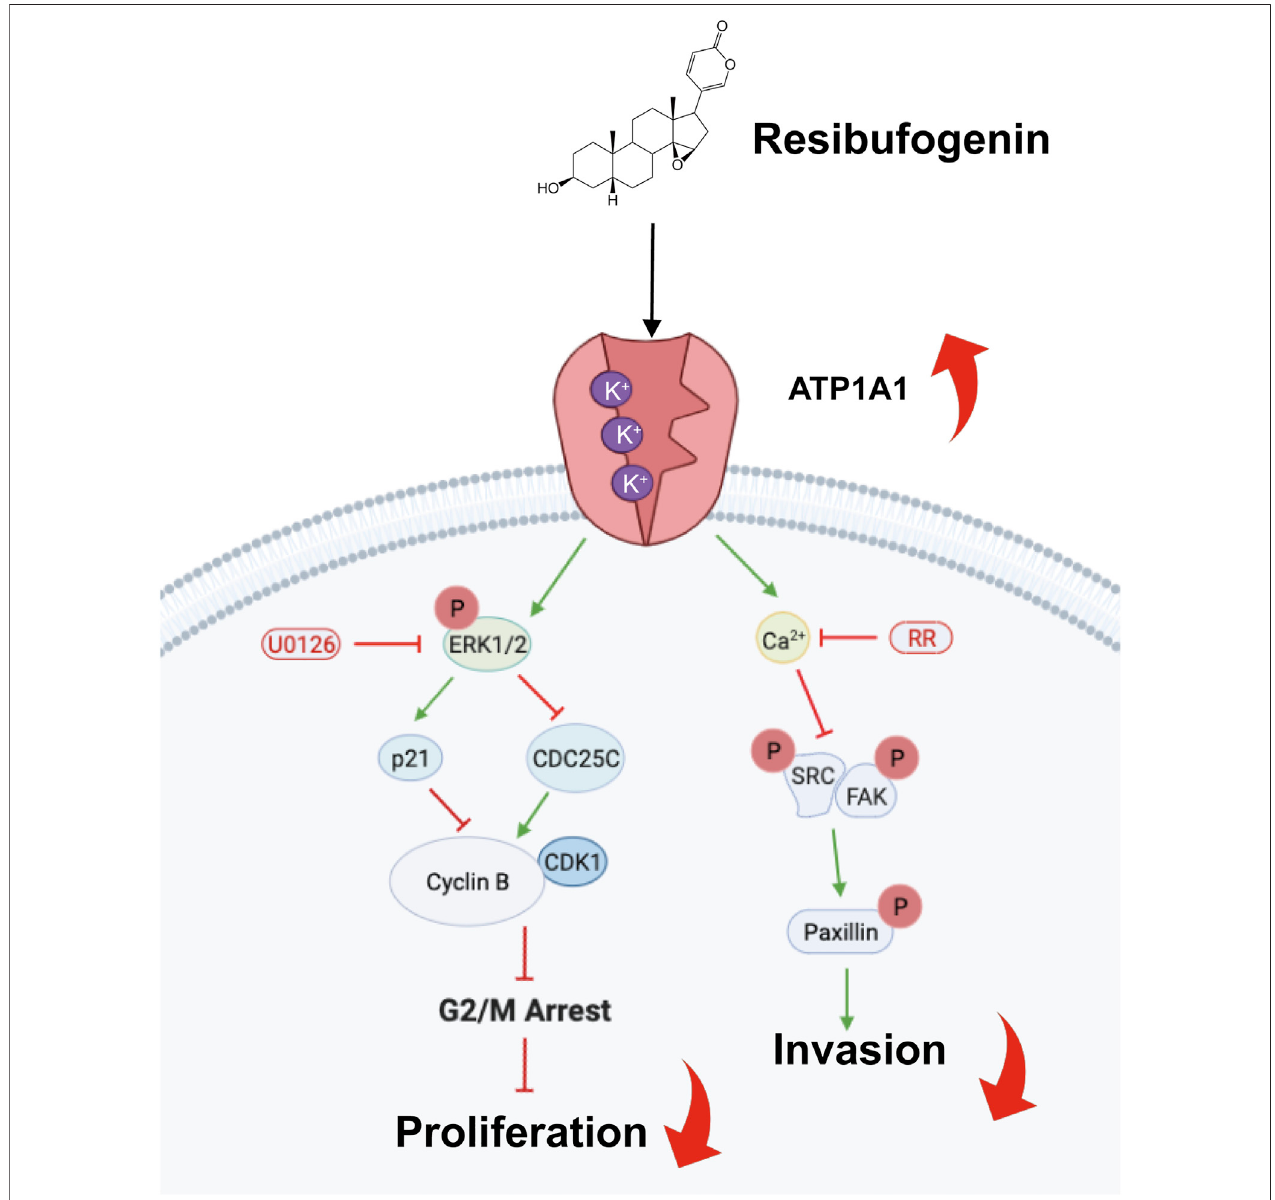
FIGURE 7 | Scheme showing the central role of RB targeting ATP1A1 and inducing G2/M phase arrest and inhibiting cell invasion.